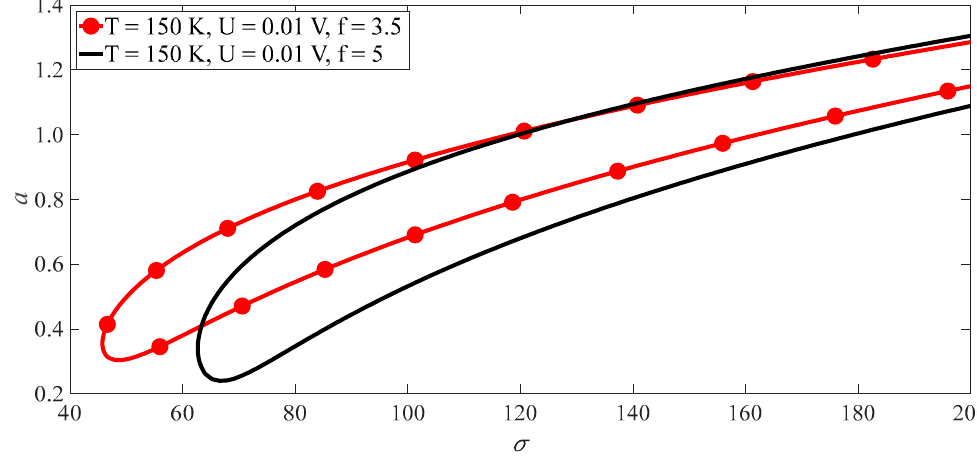
Figure 13. Amplitude detuning curves of the first mode with c 1 = 5.